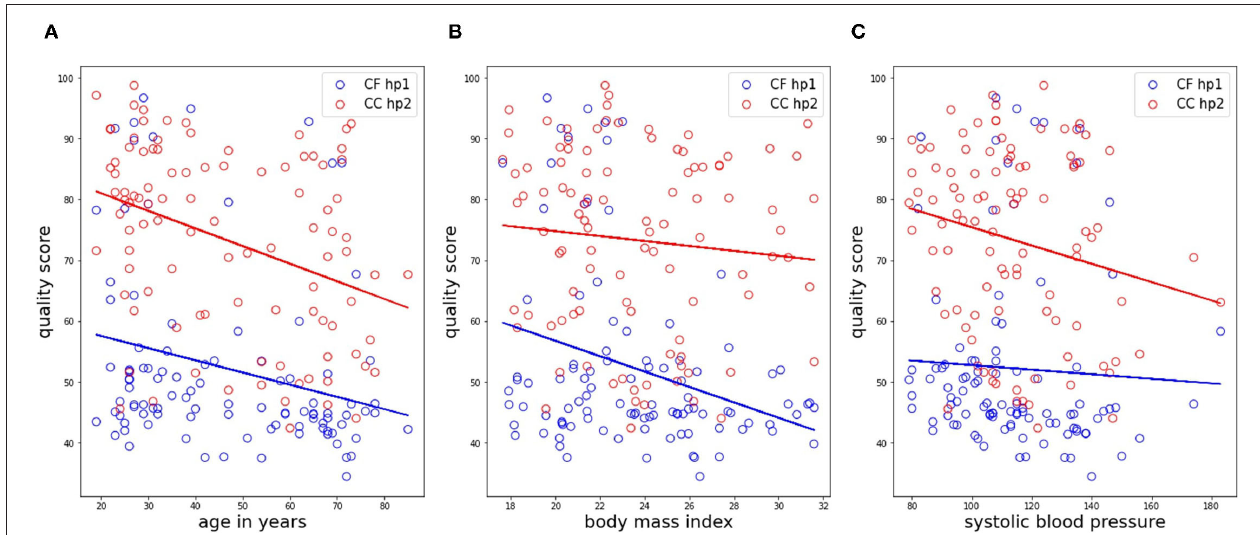
FIGURE 12 | Correlation analyses of the matrix profile-based quality score with age, BMI and systolic blood pressure, shown in subfigures (A–C) , respectively. Only data in the CC HP2 and CF HP1 cases is shown. Trendlines of the data are also